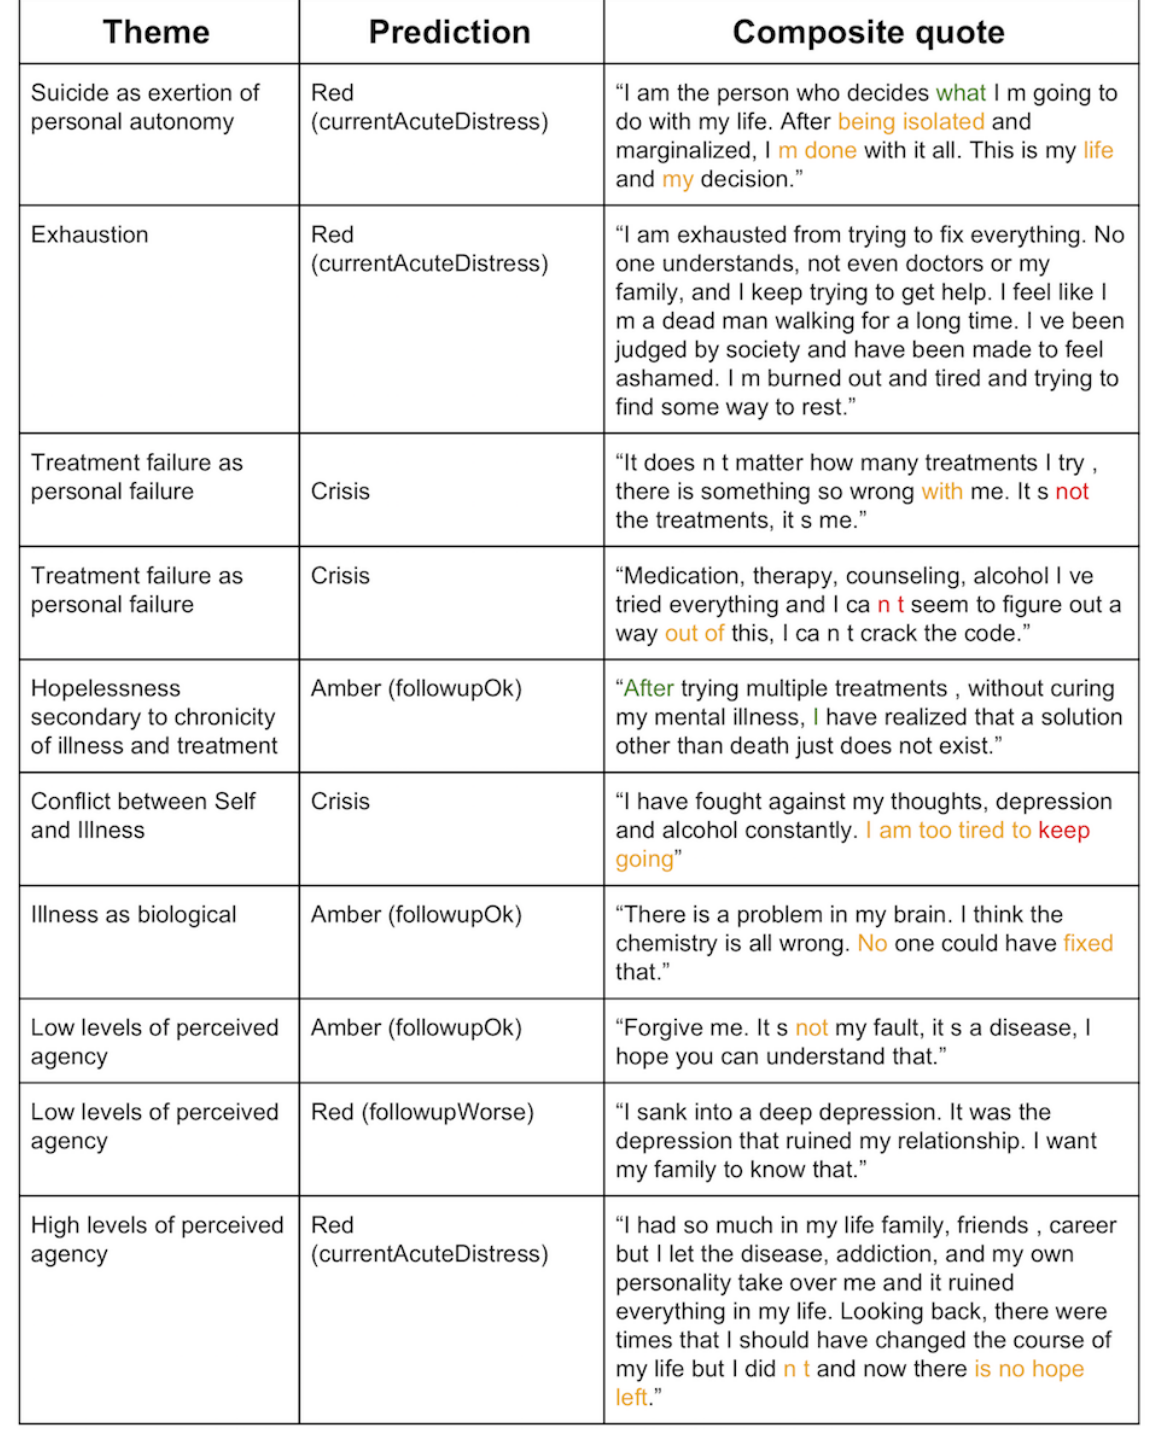
Figure 4. Predictions and highlights of suicide-related composite quotes from Furqan and colleagues. Words that changed predictions are color coded. Replacing a yellow or red word with an unknown word shifts the prediction to a less severe class by 1 or 2 levels, respectively, (ie, replacing a yellow word in text that is classified as crisis would change the prediction to red while a red word would change it to amber). In contrast, replacement of green words will result in more severe